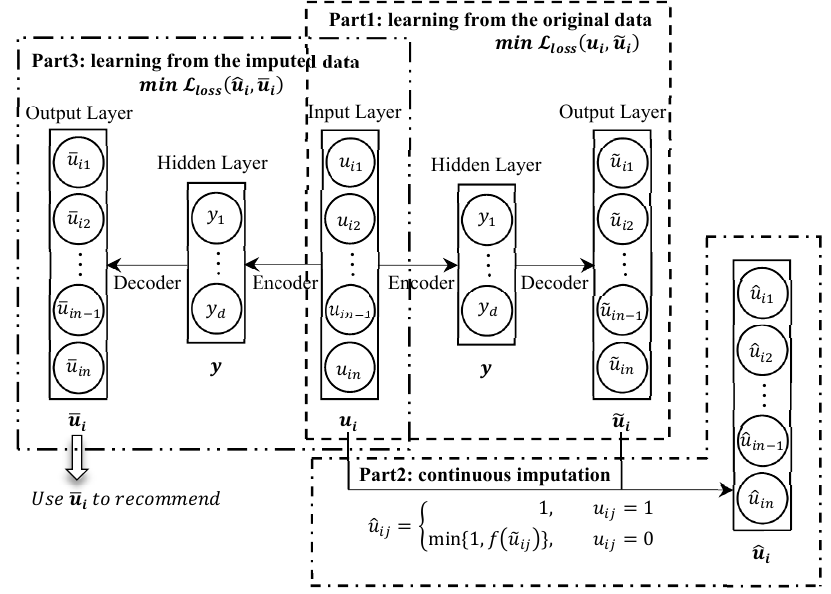
Figure 1. The structure of CIDAE.